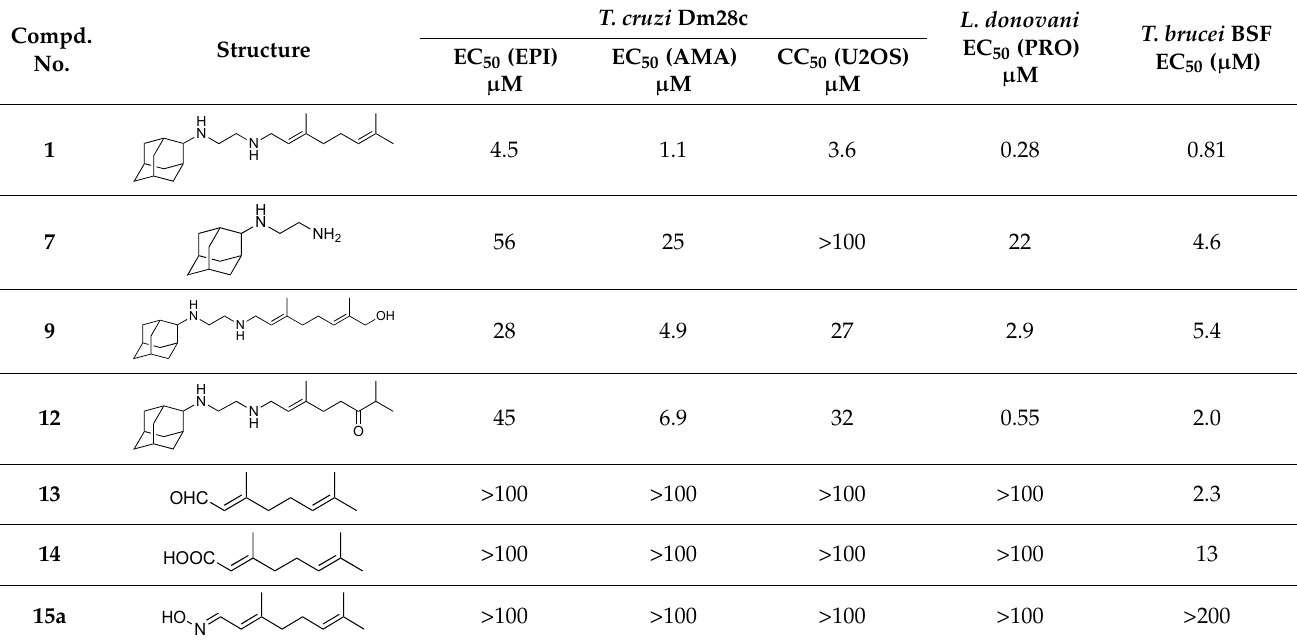
Figure 8. Representative dose-response curves, for L. donovani promastigote and T. cruzi epimastigote growth inhibition by compounds 18 , 19, 21 and 22 . ( A ) Structures of compounds investigated. ( B ) Dose-response curves for L. donovani promastigote growth inhibition. ( C ) Dose-response curves for T. cruzi Dm28c epimastigote growth inhibition. Table 1. Growth inhibition results for SQ109 and its known/potential metabolites against T. cruzi epimastigotes (EPI), T. cruzi amastigotes (AMA), T. cruzi amastigote host cells (U2OS), L. donovani promastigotes (PRO) and T. brucei bloodstream forms (BSF).